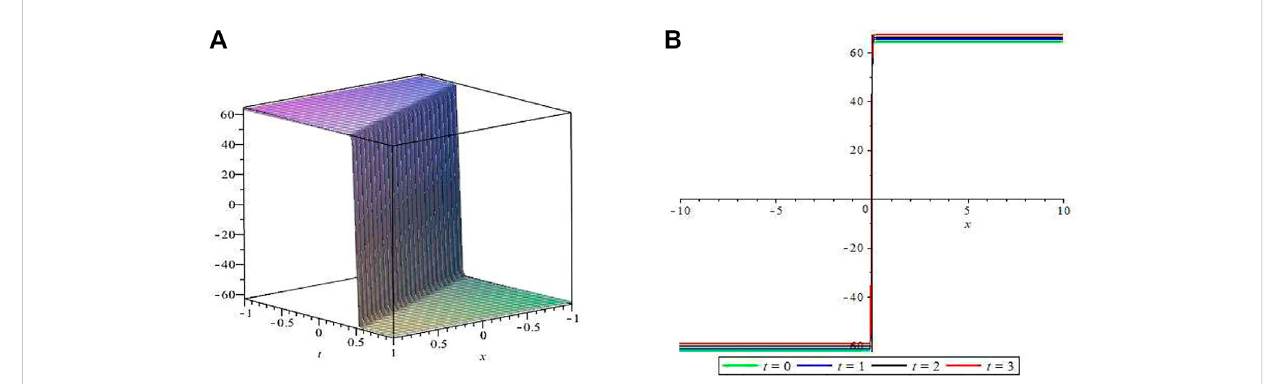
FIGURE 4 The kink wave solution of (4.57) at z =0.